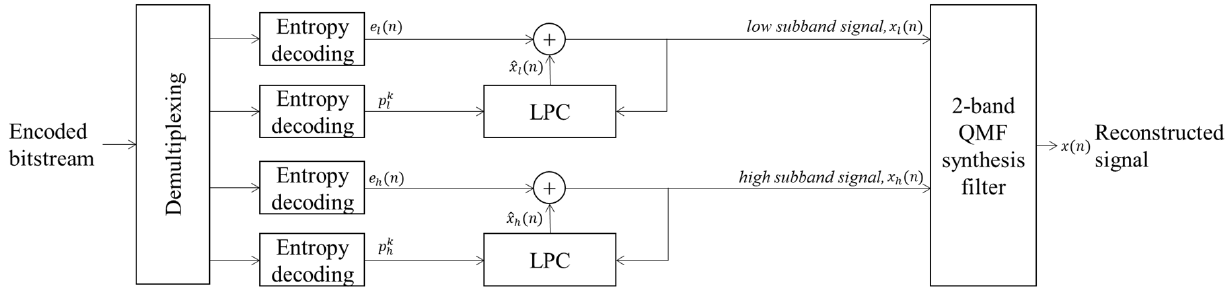
Figure 6. Block diagram of the decoder structure of the proposed